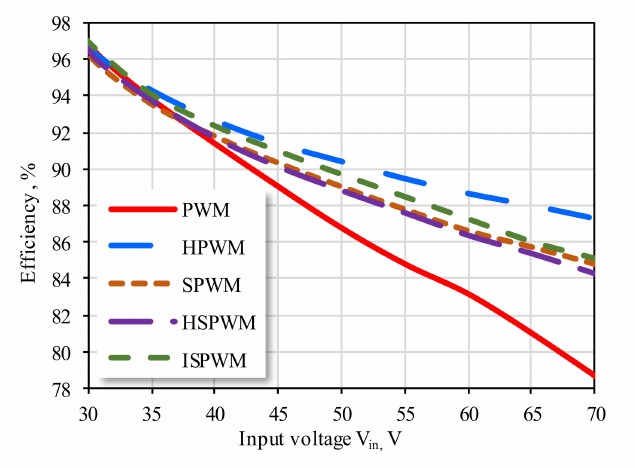
Figure 10. The measured e ffi ciency of the case study SRC for di ff erent PWM methods at P = 200